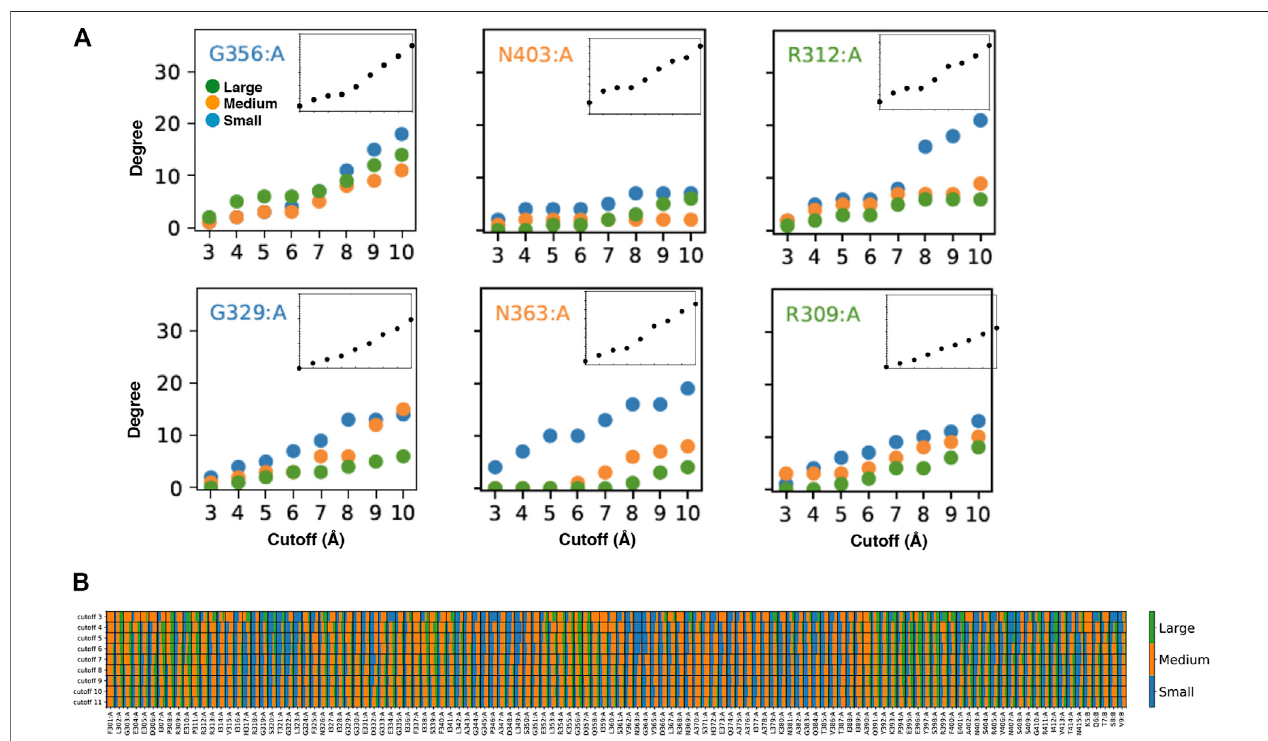
FIGURE 2 | Customized amino acid neighborhoods. (A) Degree cutoff dependencies of the small, medium and big neighbors of the AAN nodes of the 1BE9 structure.Theaminoacidsarecoloredaccordingtothelengthoftheirextendedsidechains(blue:length < 3 Å,orange:3 Å ≤ length < 5 Å,green:length ≥ 5 Å).TheInset is the total degree cutoff dependency. Top row: neighbors sizes leading to plateau degree dependencies. Bottom row: neighbors sizes leading to linear degree dependencies (B) 2D-barcode. The percentage of small, medium and big side chain neighbors are indicated for each amino acid of the 1BE9 sequence (1D, horizontal axis) and at each cutoff (2D, vertical axis). On the sequence (horizontal), (A , B) stand for amino acids from the protein and the ligand,